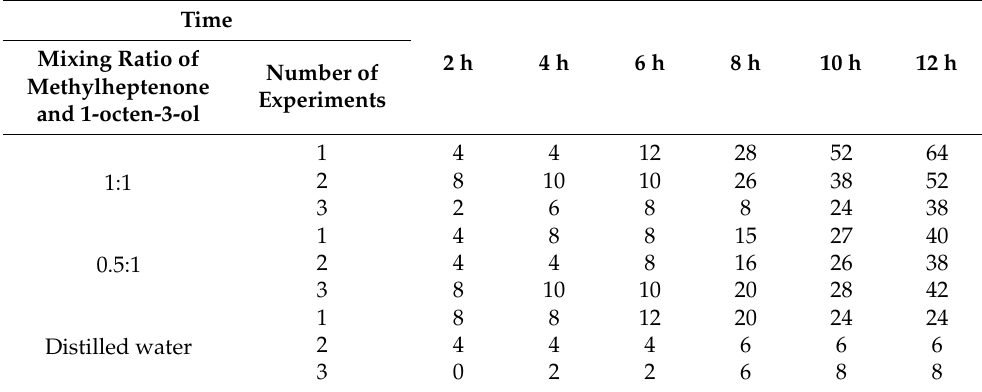
Table 8. Statistical table of the trapping for female W. magnifica by mixing methylheptenone and 1-octen-3-ol in different proportions. Time 2 h 4 h 6 h 8 h 10 h 12 hMixing Ratio of Experiments